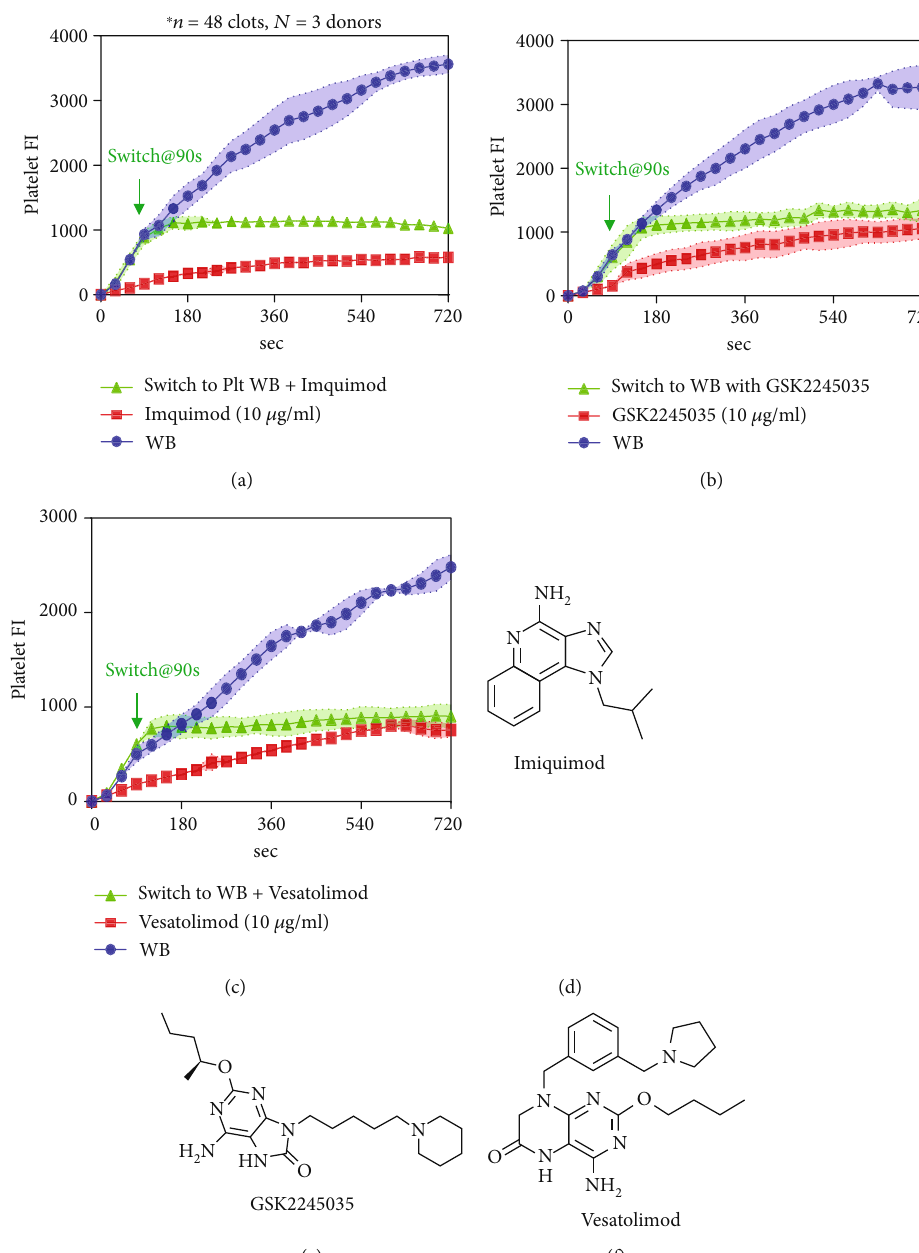
Figure 4: Activation of TLR7 can strongly inhibit platelet-platelet aggregation. PPACK WB treated with control (HBS); TLR7 ligands were perfused over collagen at 100s -1 with or without switching. CD61 was used to label platelets. Fluorescence intensities for platelets were measured throughout the course of the experiments for Imquimod (a), GSK2245035 (b), and Vesatolimod (c). Molecular structure of di ff erent TLR 7 ligands were shown in Figures 4(d), 4(e), and